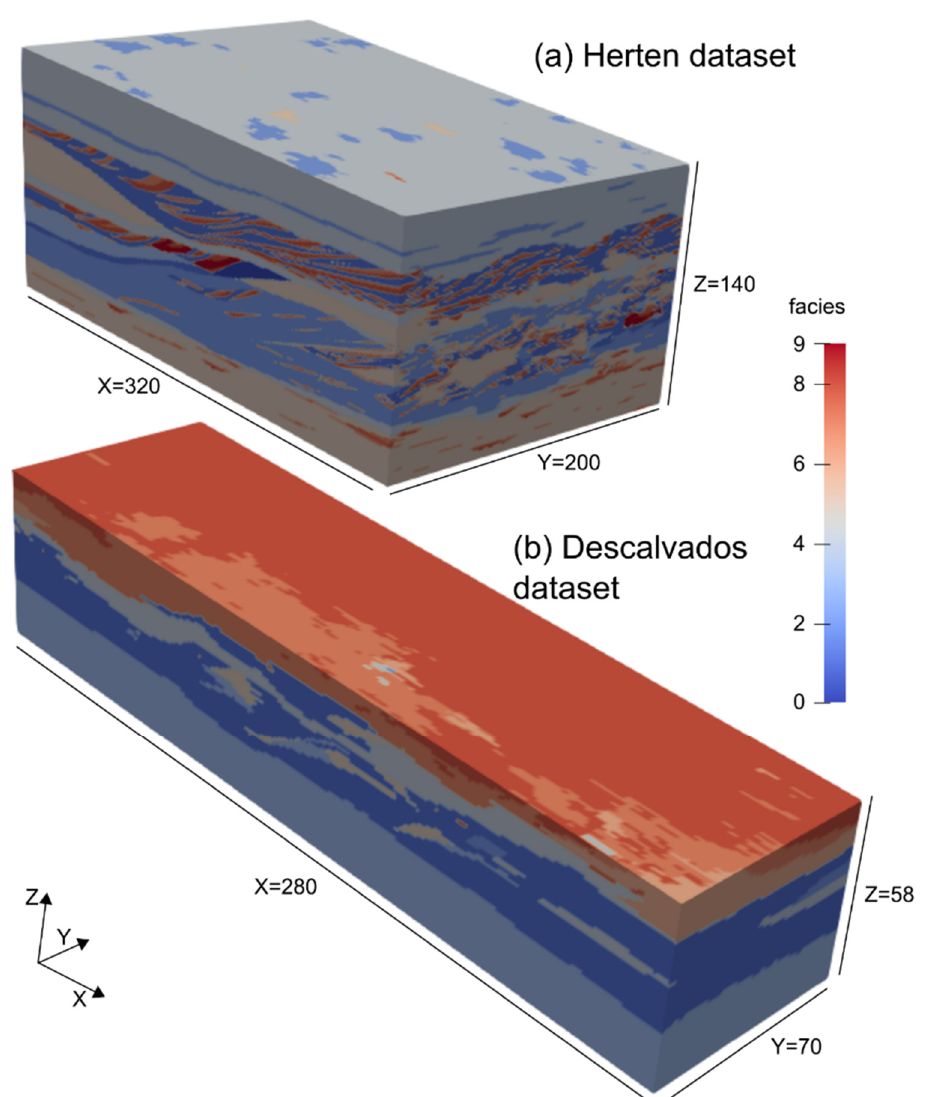
Figure 10. ( a ) The Herten and ( b ) Descalvado aquifer analogues analysed in this study.